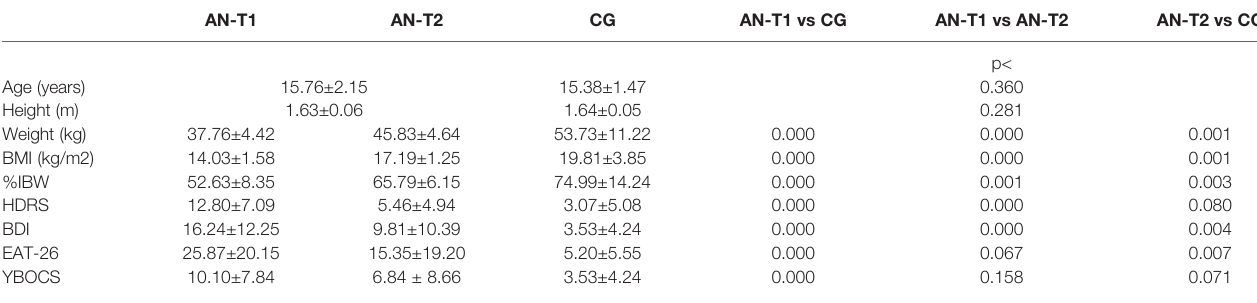
TABLE 1 | Anthropometric and psychometric data, in the adolescent anorexic inpatients in acute stage of the disease (AN-T1) as well as after partial weight recovery (AN-T2), and in the control group (CG).